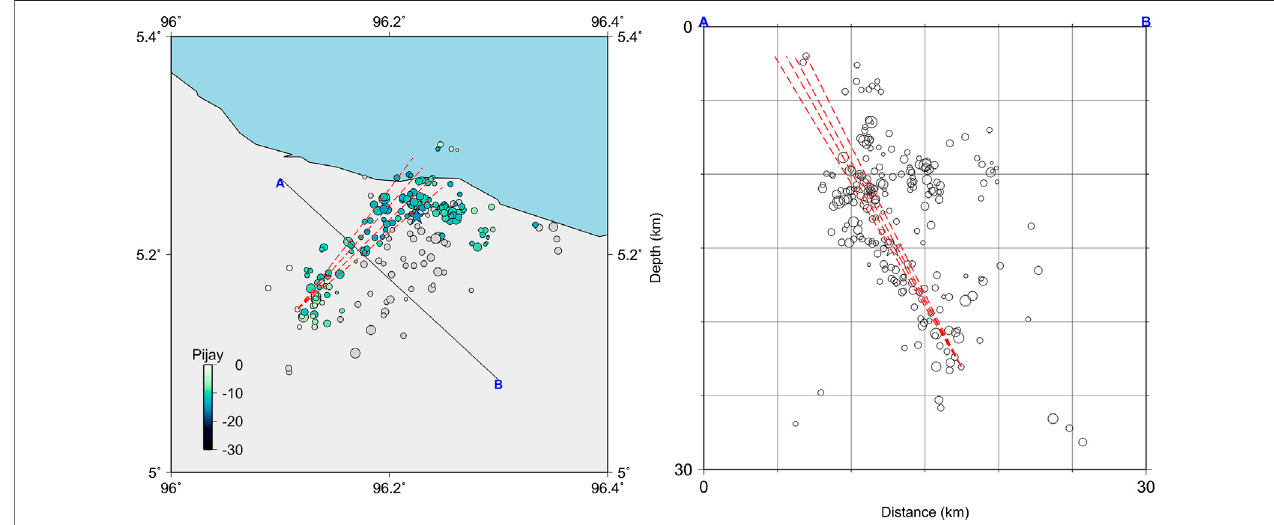
FIGURE 4 | Strike and dip estimation of Panteraja Fault based on the 2016 Pidie Jaya aftershock distribution (Muzli et al., 2018). The star depicts Pidie Jaya mainshock from the Global Centroid Moment Tensor.